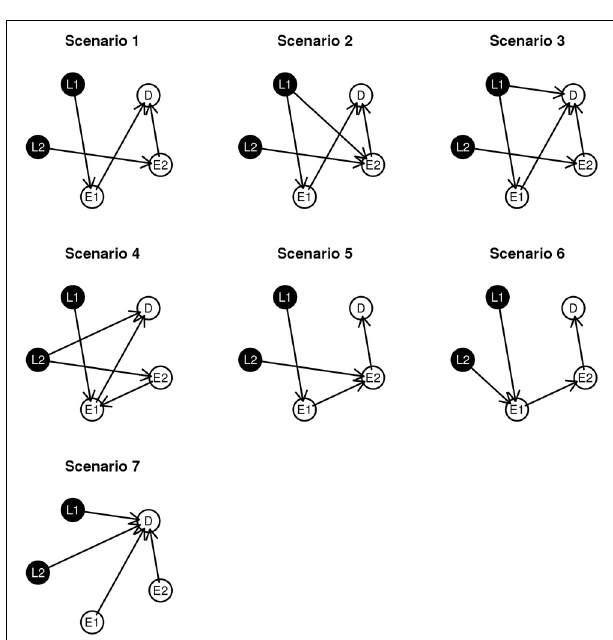
FIGURE 3 | Graphical representation of the simulation